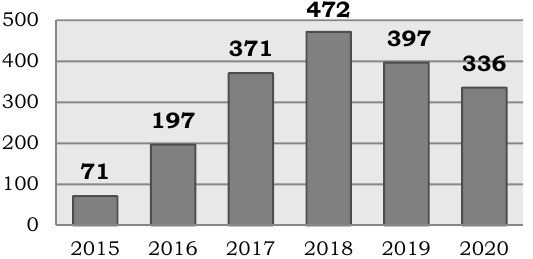
Figure 3. Number of donors annually incorporated into the Andalusian Registry of Donors for Biomedical Research since its creation in 2015.